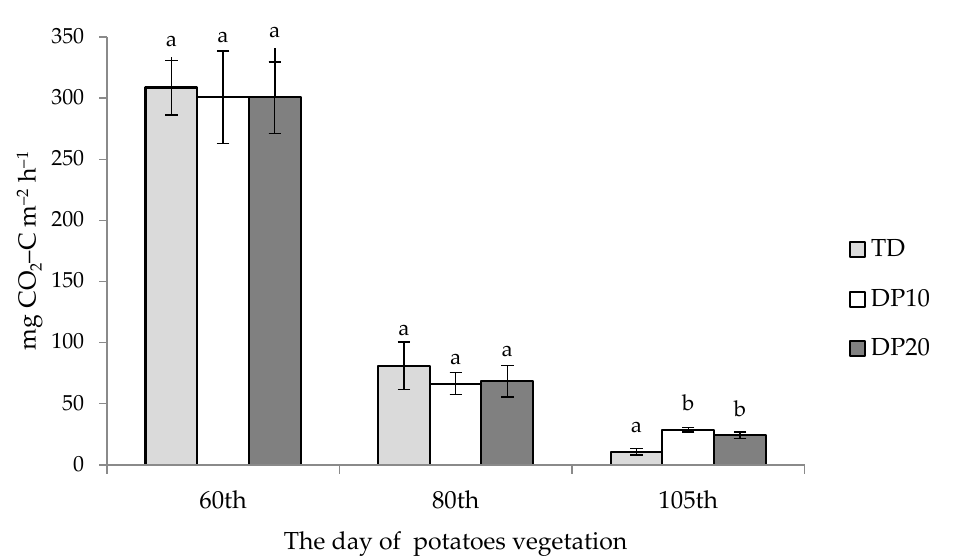
Figure 4. Soil CO 2 flux under the influence of TD, DP10, and DP20 fertilization in a field experiment in Kukl ó wka Zarzeczna (Central Poland). Different letters (a, b) indicate significant differences ( p < 0.05) among treatments (TD, DP10, and DP20) (separately for test dates).